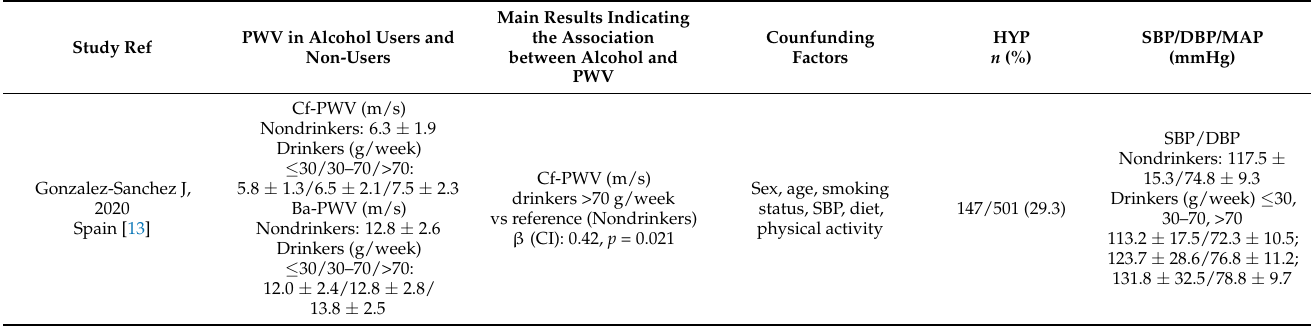
Table 4. Main findings of the included